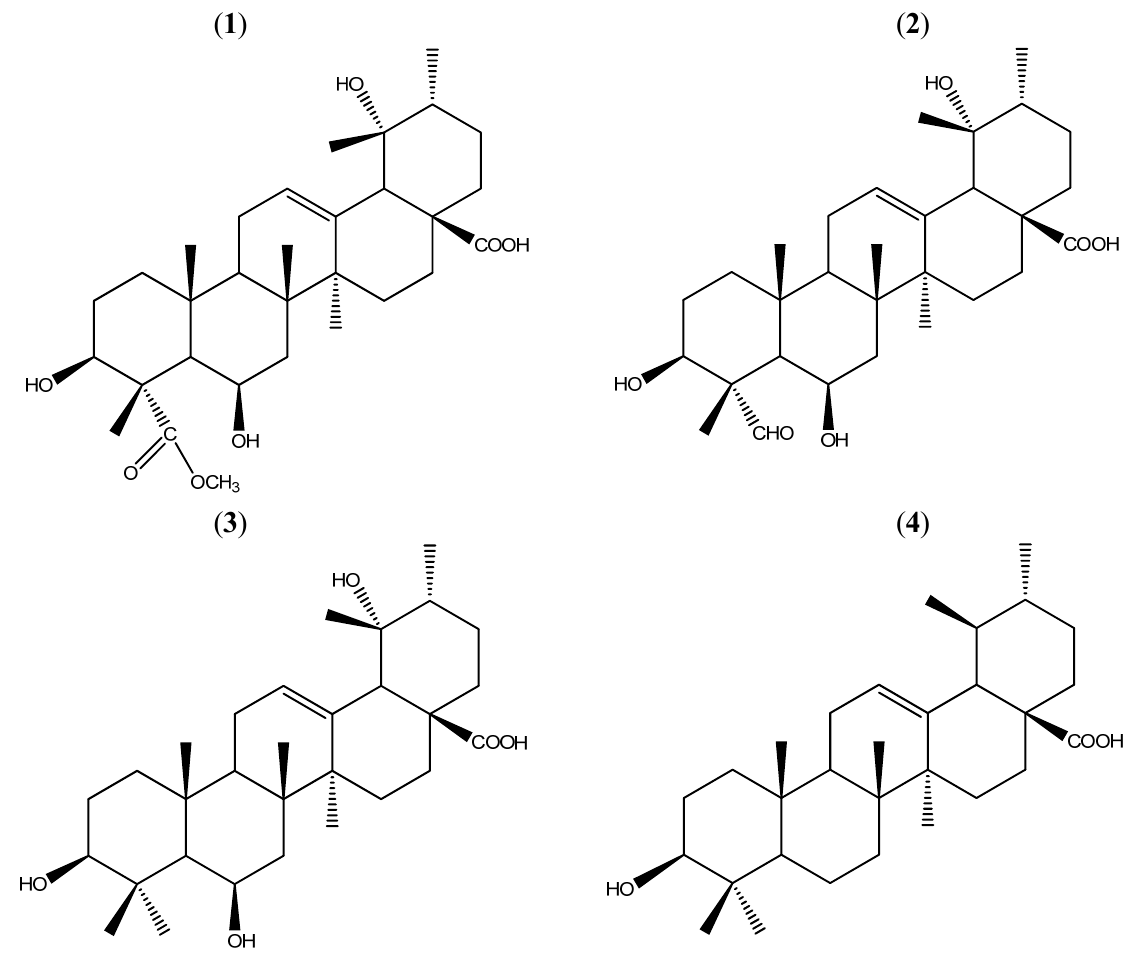
Figure 1. Structures of 1 – 4 . Compounds 1 – 4 were isolated from the chloroform